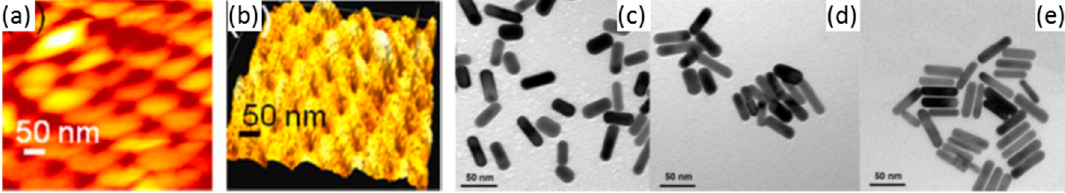
Figure 16. ( a , b ) show the nanoporous structure observed from a hybrid polymer—metallic structure; ( c – e ) images on the right hand side display gold nanorods with aspect ratios to detect immunoglobulins. Reprinted from [62,63] with permission from Elsevier.